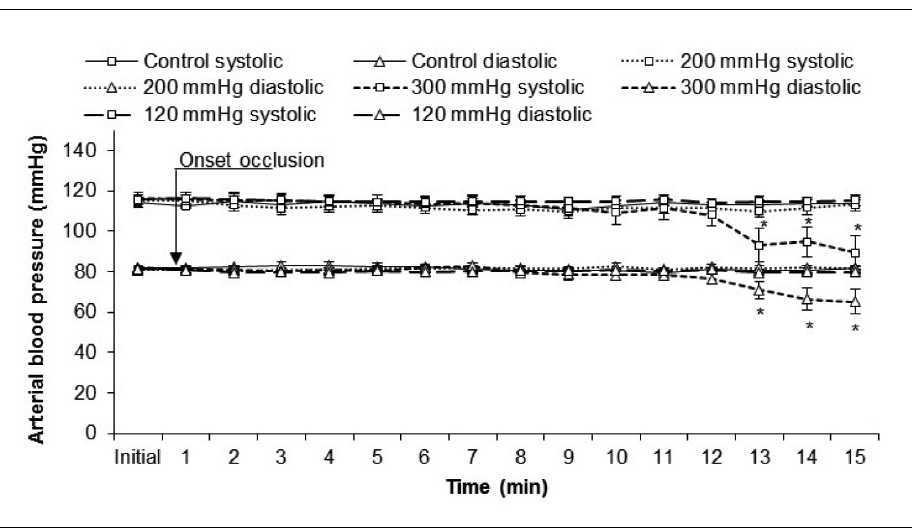
Figure 2. Changes of arterial blood pressure in experimental groups during 120; 200 or 300